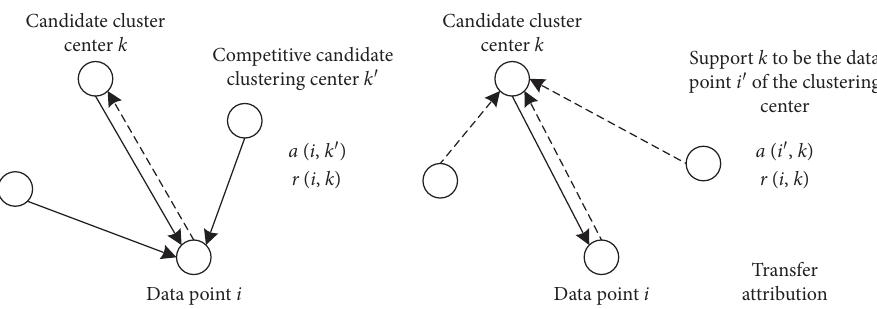
Figure 2: AP clustering algorithm message transmission.